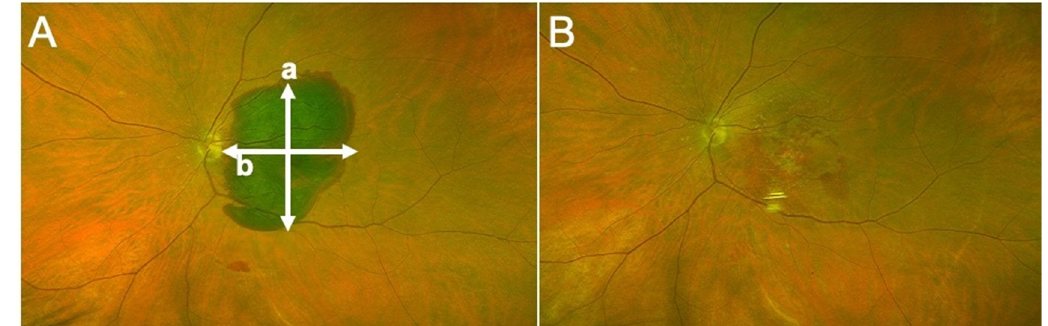
Figure 1. ( A ) Fundus photograph of a 70-year-old female with macular hematoma of her left eye, due to type 1 choroidal neovascularization consecutive to age related macular degeneration. (a) Vertical diameter, (b) horizontal diameter. ( B ) Surgery was performed 4 days after presentation, allowing complete displacement of blood from the foveal region.